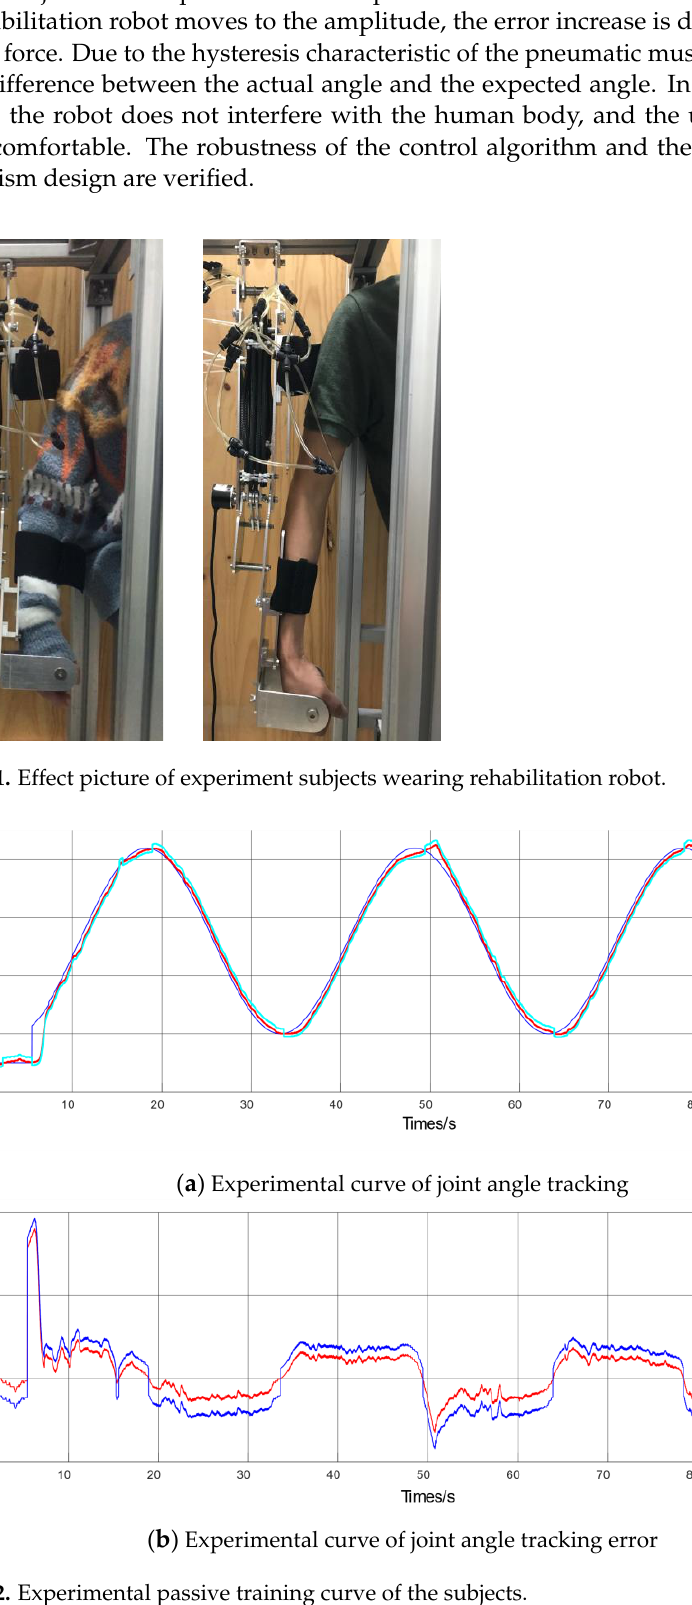
Figure 12. Experimental passive training curve of the subjects.